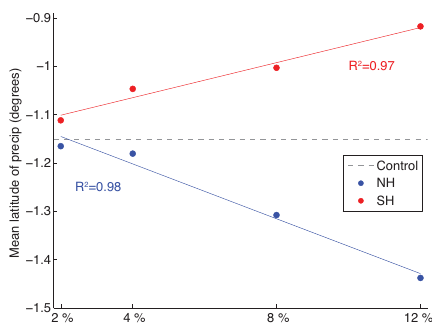
Figure 9. Linear regression over the precipitation centroid ( χ ; Eq. 1) results from all of the step response simulations. Regressions were performed over the average values of χ over years 11–30 of simulation. χ is approximately linear with perturbation